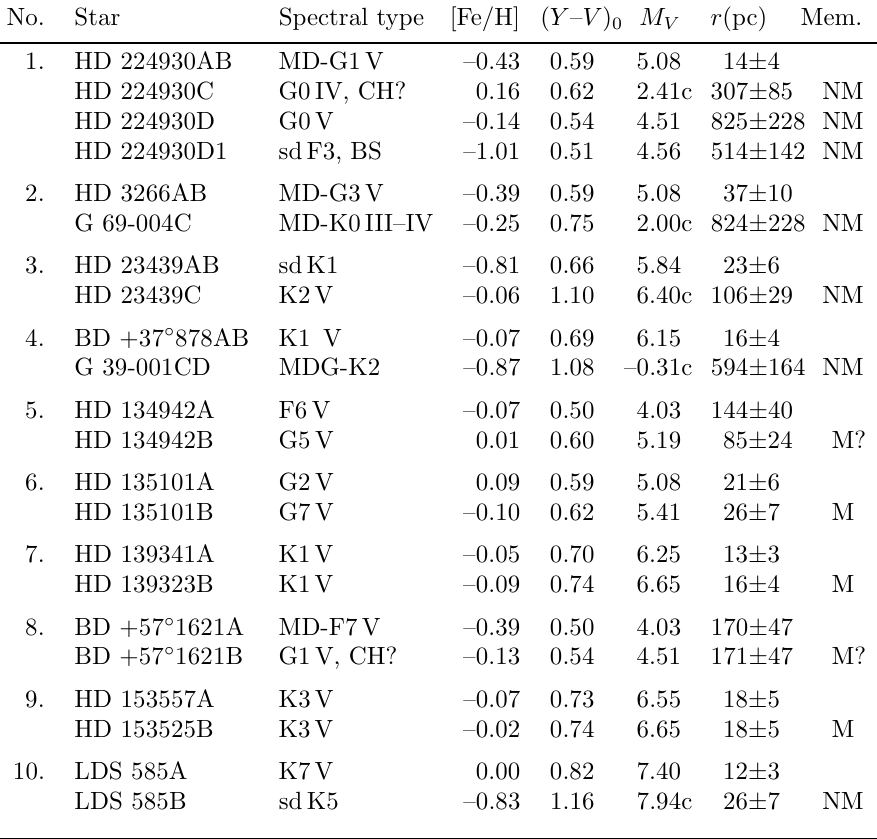
Table 2. Results of classification of Population II visual